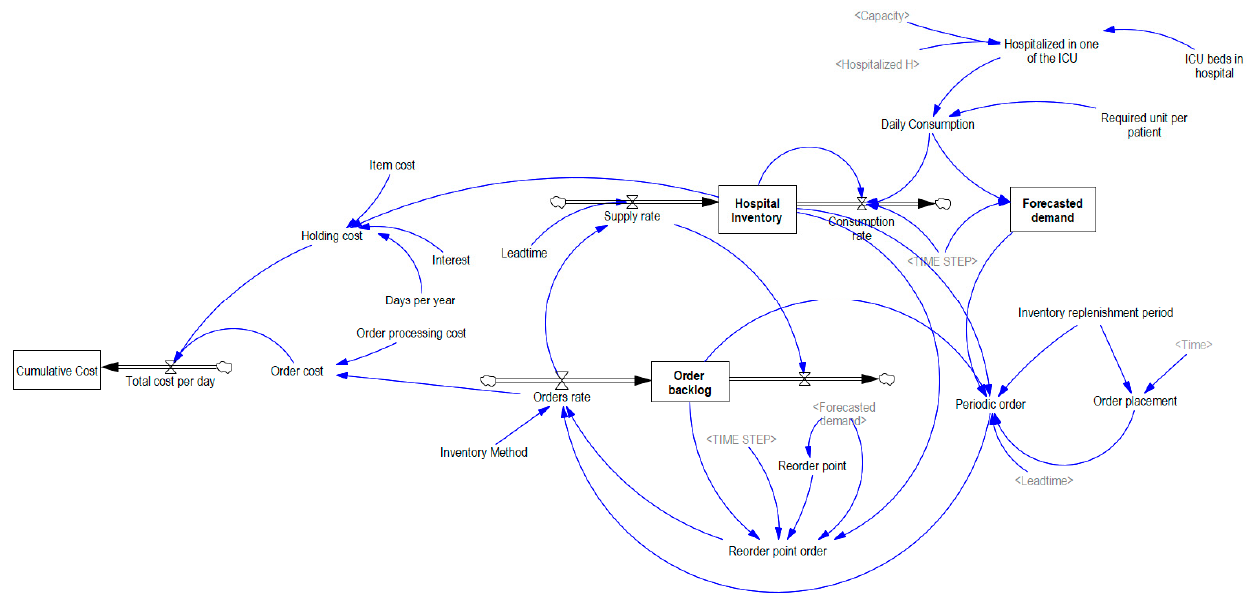
Figure 2. Proposed model to estimate the hospital inventory.